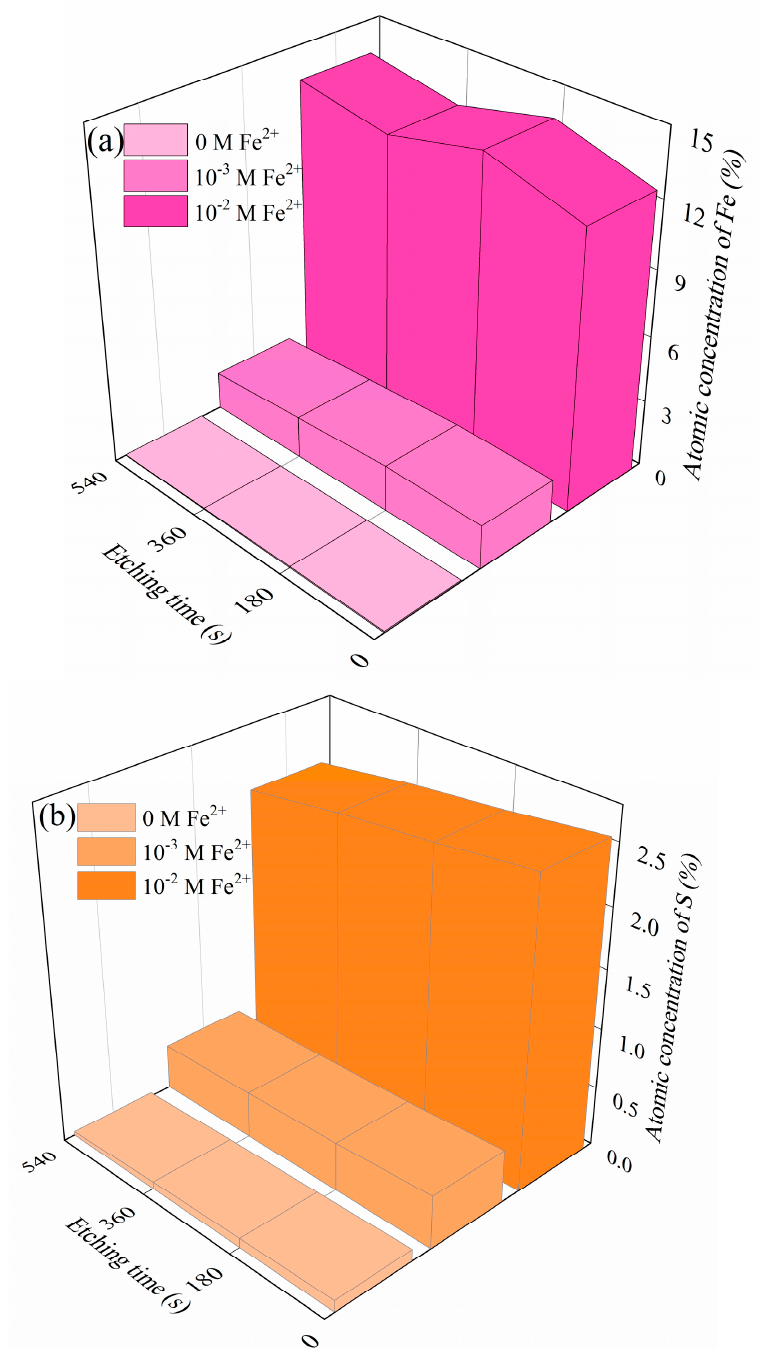
Figure 4. The depth profile for Fe ( a ) and S atomic percentage ( b ) of dolomite with and without the treatment of Fe 2+ (c(SBX) = 10 − 3 M SBX).